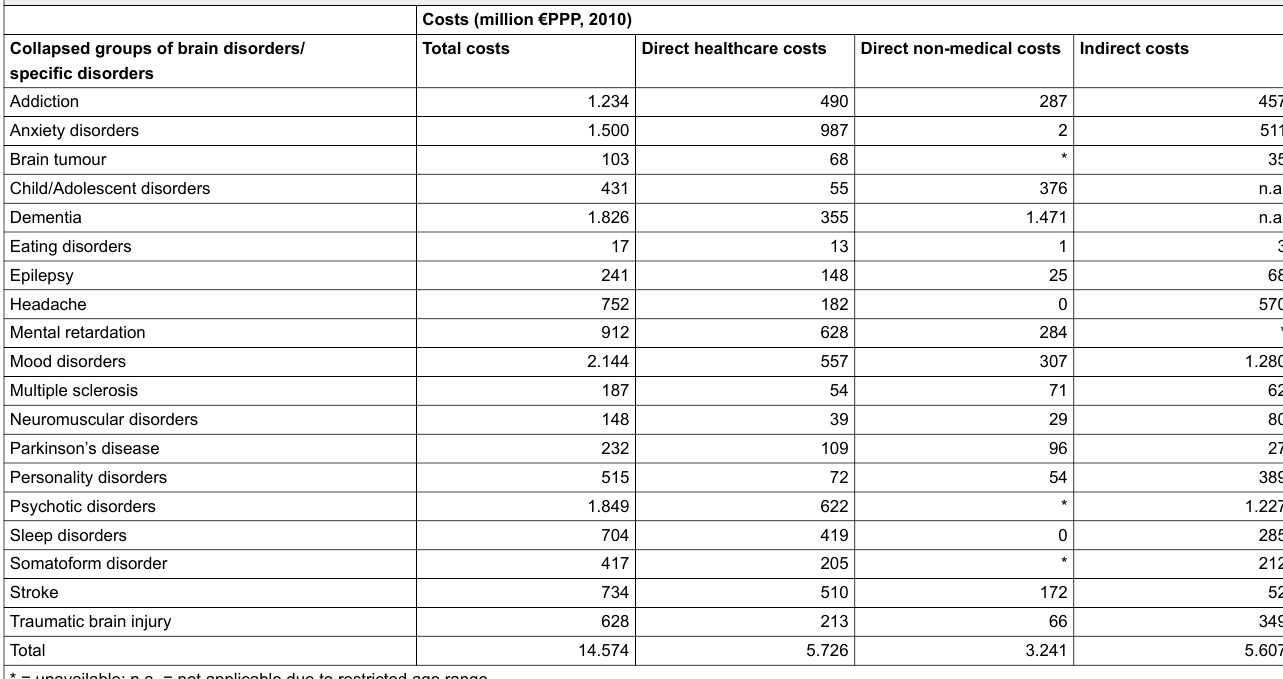
Table 1: Total costs of direct healthcare-, non-medical- and indirect costs.